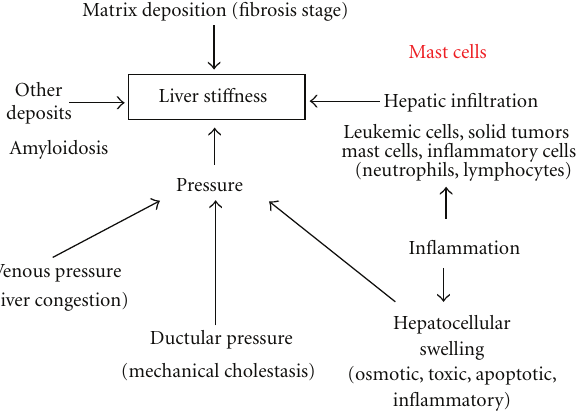
Figure 4: Present clinical algorithms for the interpretation of increased liver sti ff